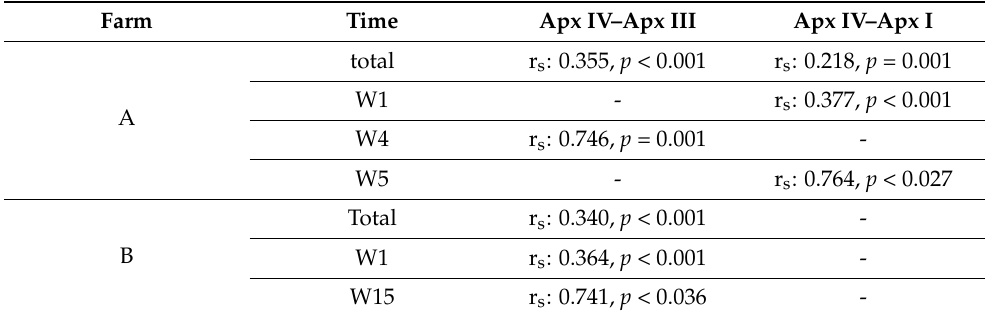
Figure 4. Boxplots of log10 c/µL Apx I-toxin DNA load in OFs of farm A within study week one and over the entire study period at a weekly basis. Table 2. Correlations (Spearman’s rho) between the quantitative outcome of the Apx-PCR result of different Apx-toxin DNA at different times of sampling and the entire study